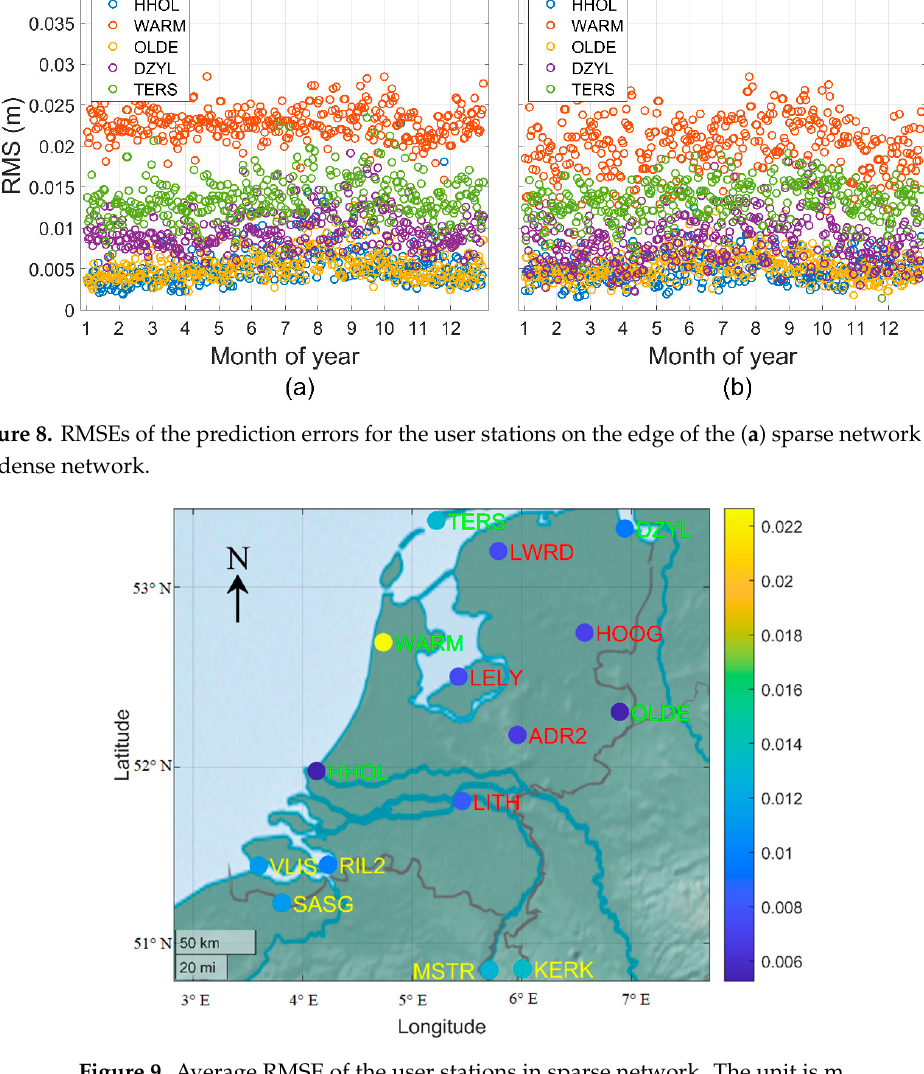
Figure 9. Average RMSE of the user stations in sparse network. The unit is m.